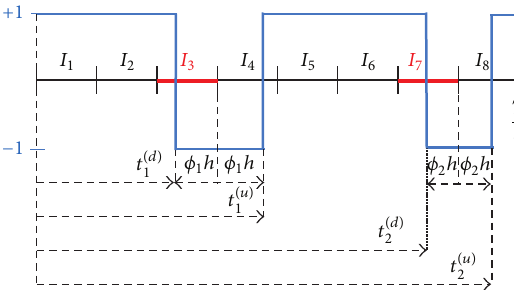
Figure5:Switchingstructureinthe advanced designmethod .Inthis case, each pulse is chosen to be symmetric with respect to a certain partition